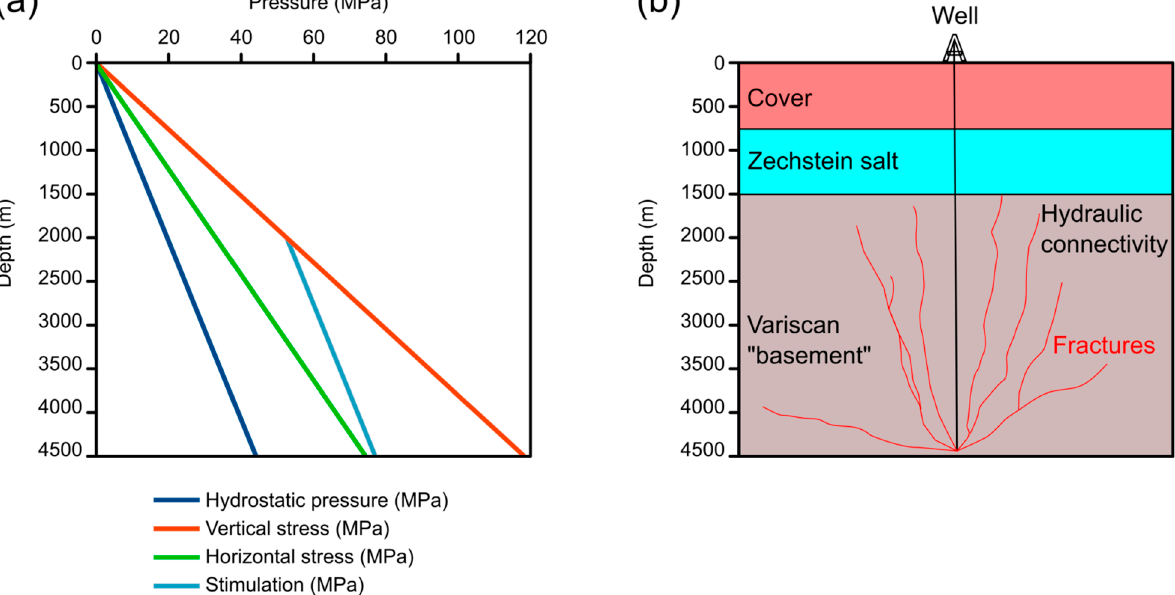
Figure 8. Possible effects of stimulation at a depth of 4.5 km on the rocks at a depth of 2 km, modelled for a greywackes and slates with a geostatic stress ratio of 0.41. ( a ) Graph of pressure against depth. ( b ) Schematic cross ‐ section. At a depth of 4.5 km, hydrostatic fluid pressure = 44.15 MPa, σ V = 118.31 MPa and σ h = 74.55 MPa. At a depth of 2 km, hydrostatic fluid pressure = 19.62 MPa, σ V = 52.58 MPa and σ h = 33.14 MPa. If there is hydraulic connectivity through the greywackes and slates, increasing fluid pressure at 4.5 km to above 77 MPa, such that it exceeds σ h , would increase fluid pressure at 2 km 52.58 MPa, at which point it will equal σ V .